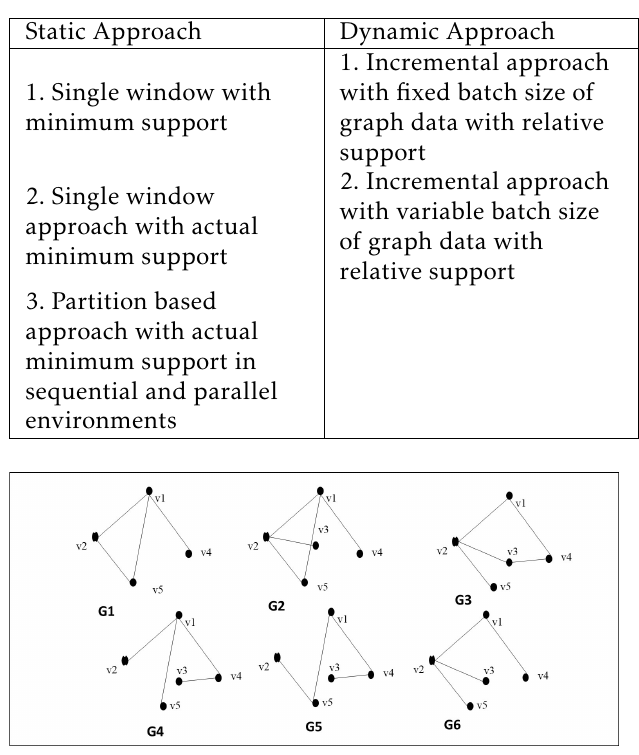
Table 1. Proposed Approaches and its variations